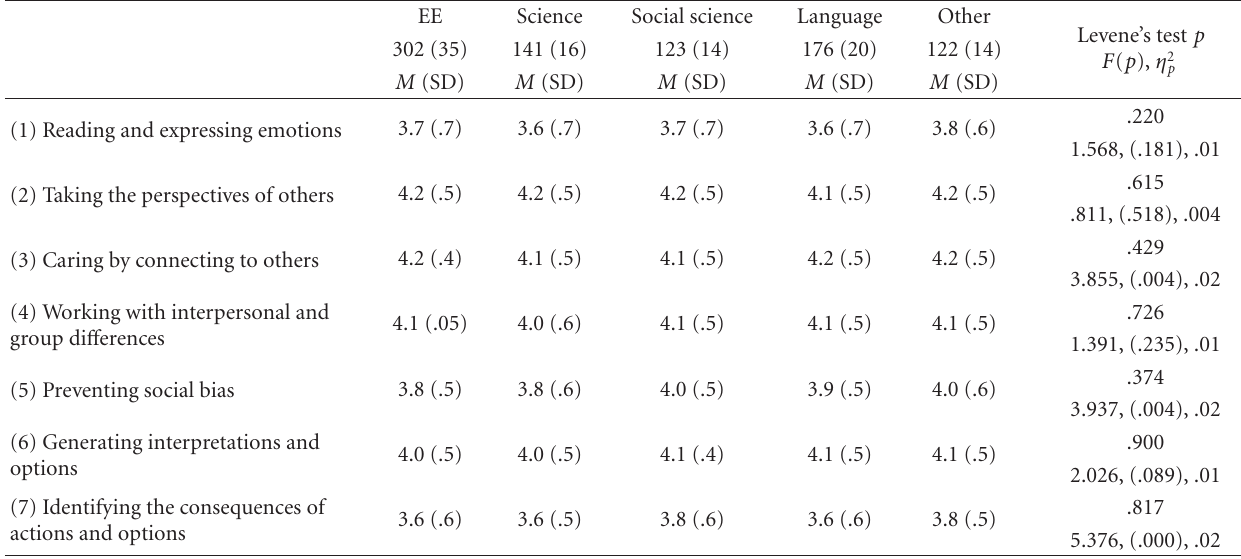
Table 4: Subject-related di ff erences in ethical